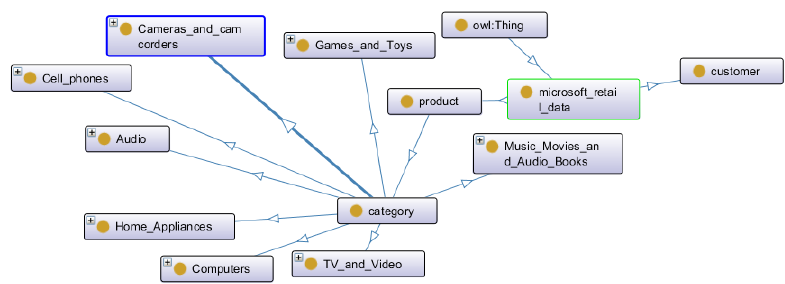
Figure 8. Online retail ontology onto-graph.